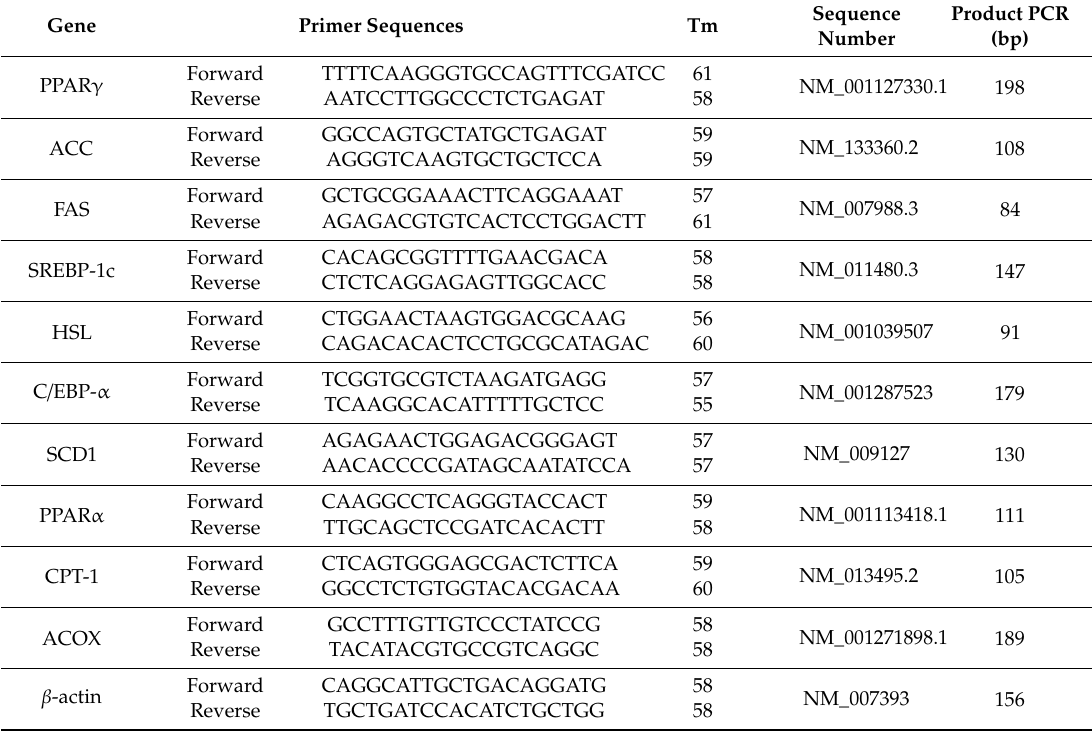
Table 2. Primer sequences of detected